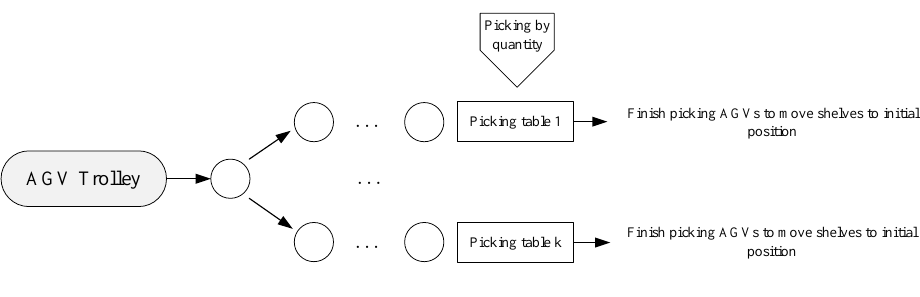
Figure 7. The model of AGV